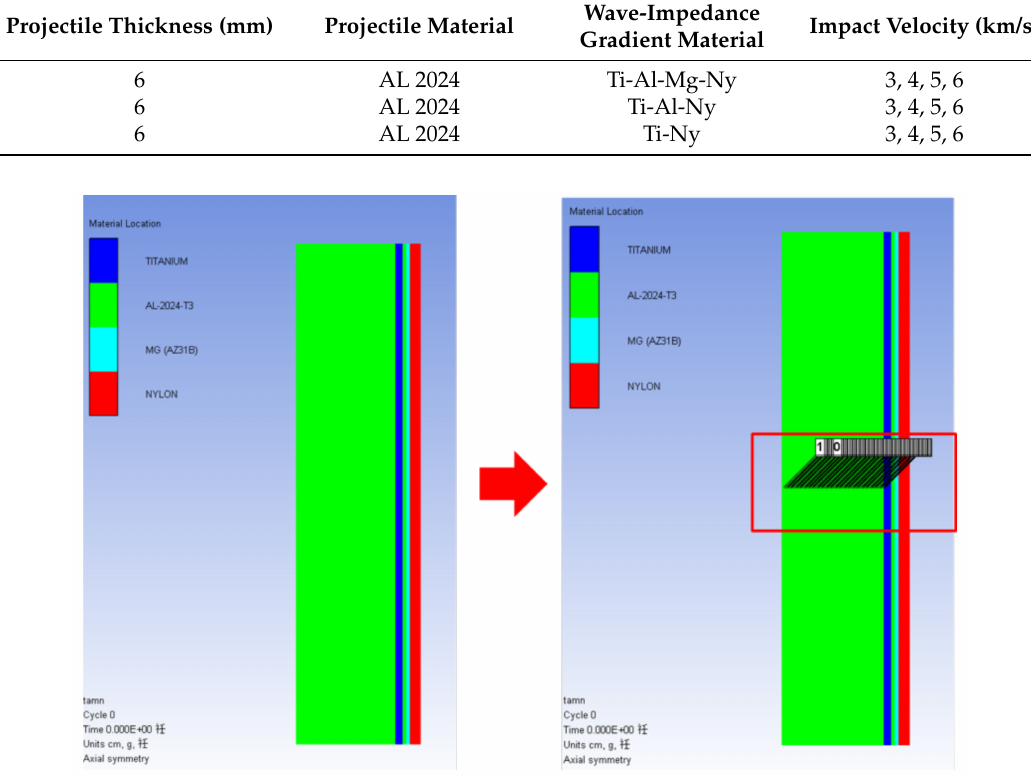
Figure 8. One-dimensional strain-collision model.